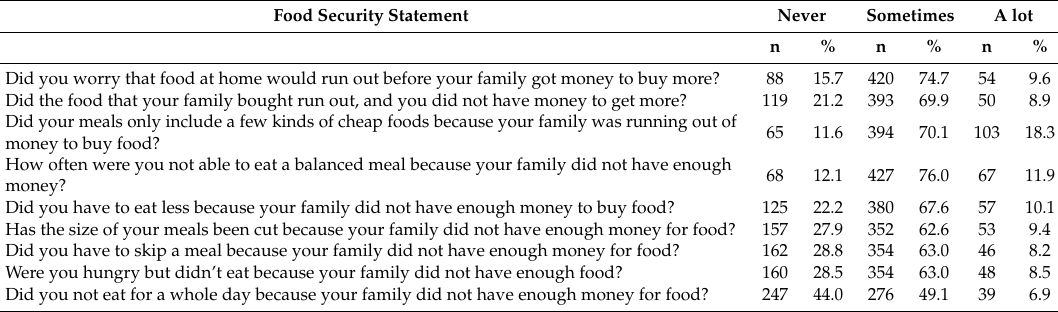
Table 1. Food security distribution among respondents (n =